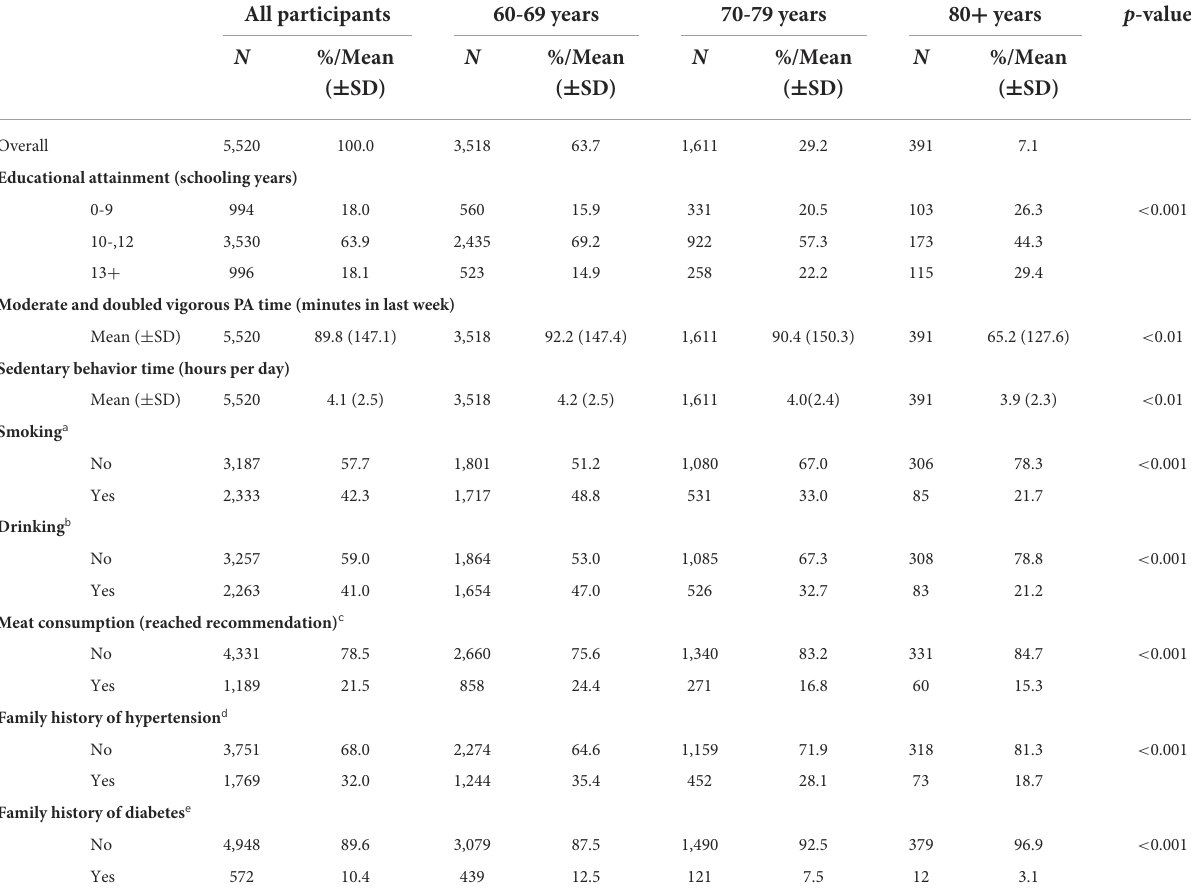
TABLE 1 Selected characteristics of participants by age in this